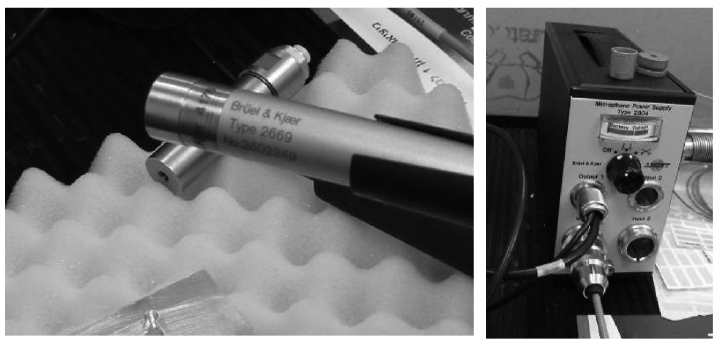
Fig. 67. Br¨uel & Kjær type 2669 Microphone and power supply unit.